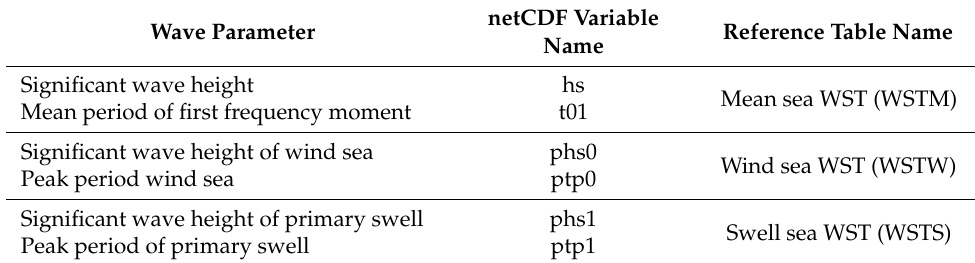
Table 1. Developed WST hindcast file